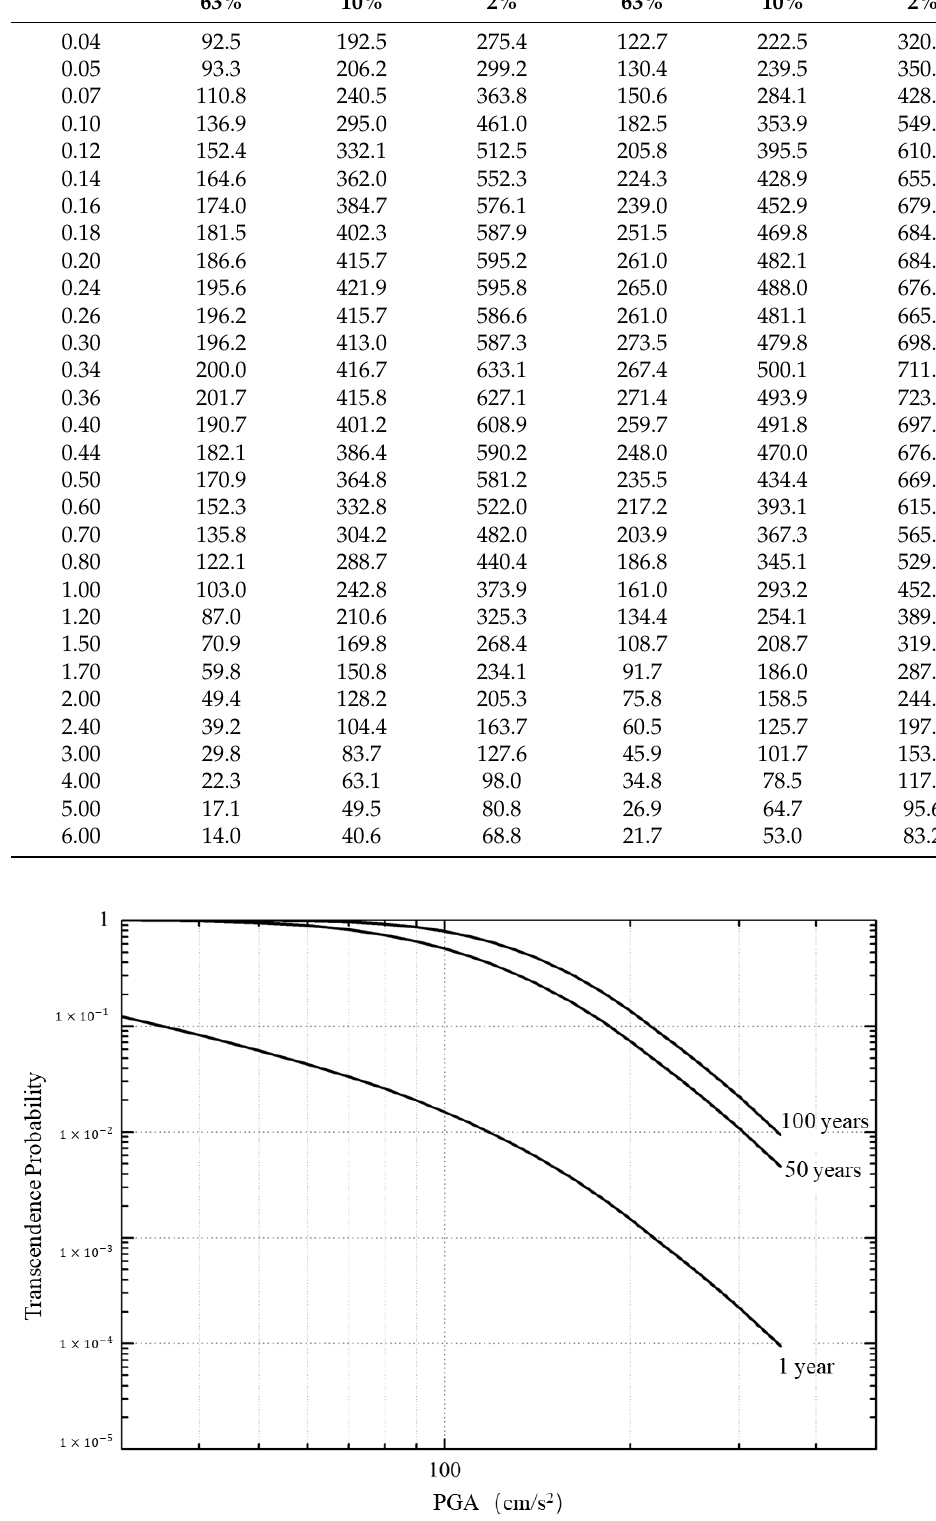
Figure 4. Response spectrum curve of the bedrock horizontal acceleration at the engineering site of Najin Lhasa.